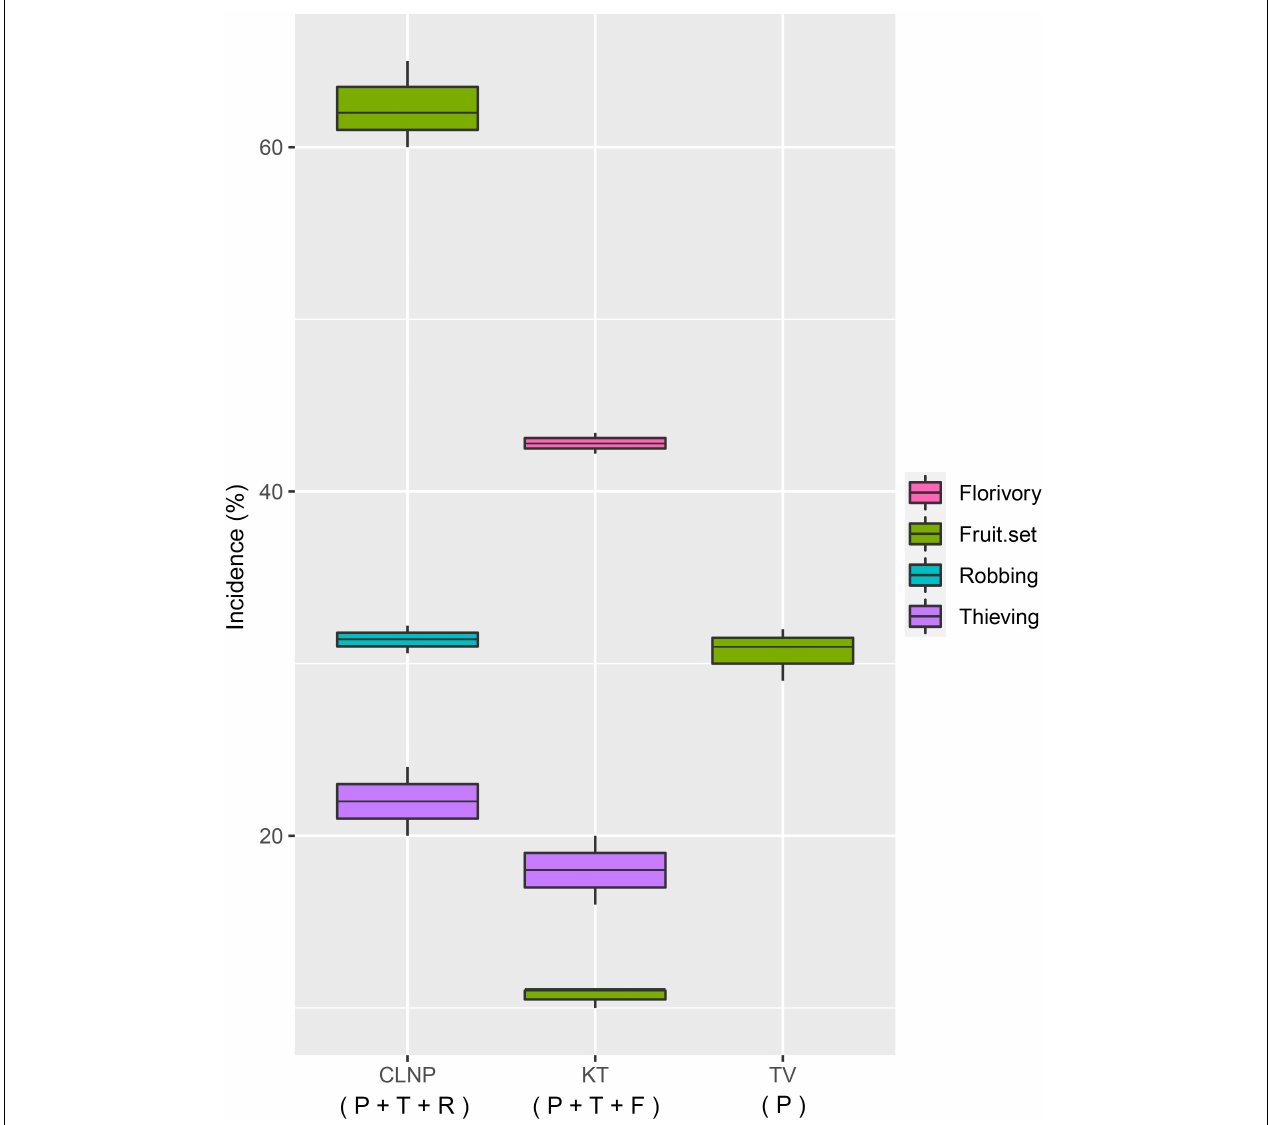
FIGURE 3 | Incidence of thieving and robbing, florivory, and natural fruit-set, expressed as a percentage in different populations of A. odorata. P, pollinator; T, thief; R, robber; F,